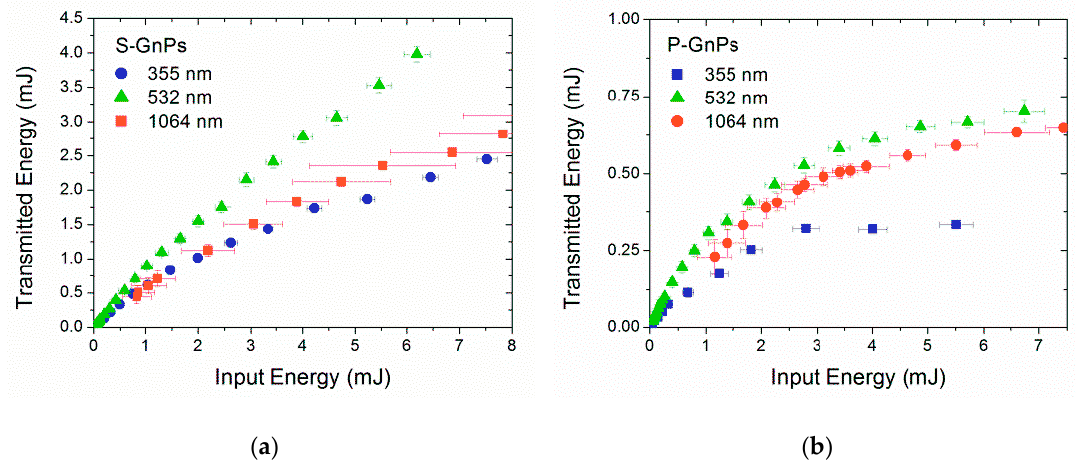
Figure 5. Transmitted energy as a function of the incident energy in the non-linear regime, for both S-GnPs ( a ) and P-GnPs nanofluids ( b ).